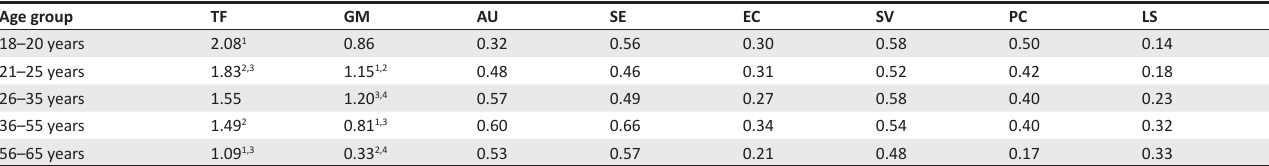
TABLE 8: Career anchors and age in the short term (1 to 3 years). Age group TF